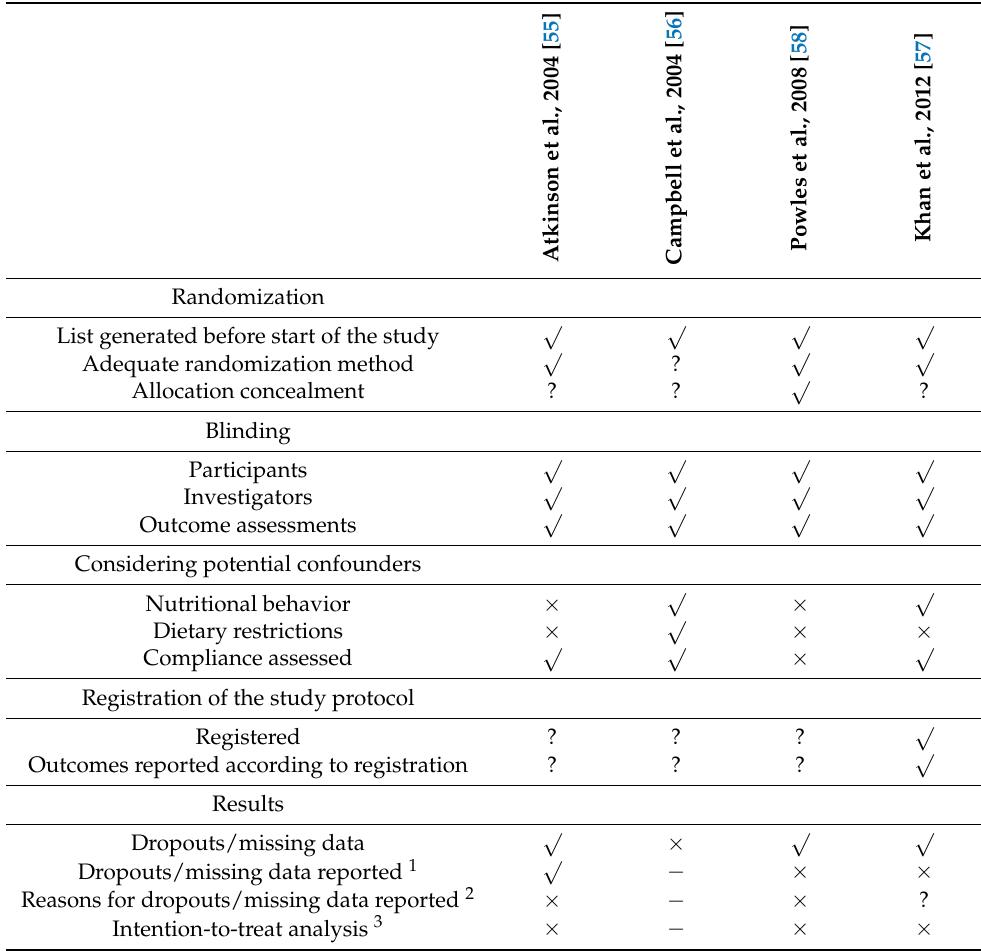
Table 6. Criteria to assess the risk of bias in studies with a mixed group of pre-, peri- and post- menopausal